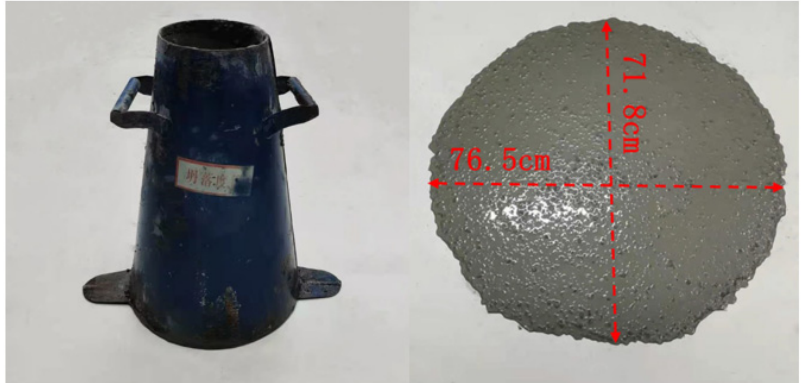
Figure 5. Slump expansion of concrete.